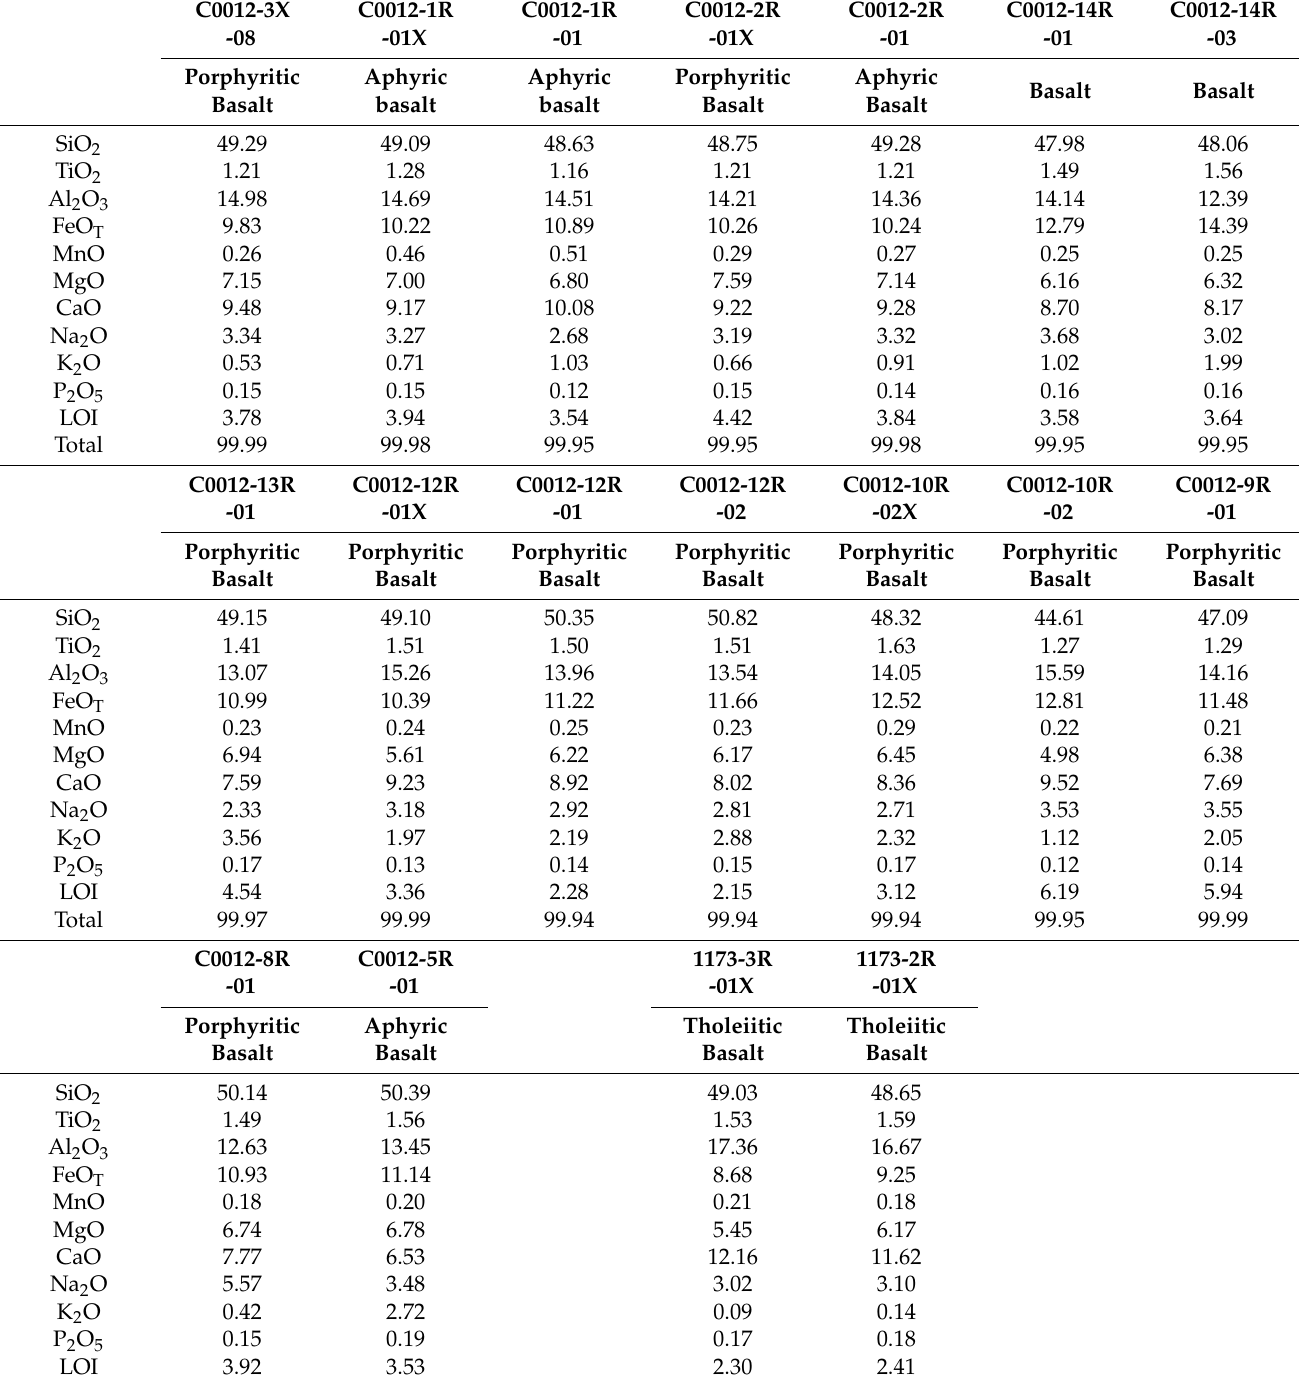
Table 1. Major-element (wt.%) concentrations of Site C0012 and Site 1173 volcanic rocks from the Shikoku